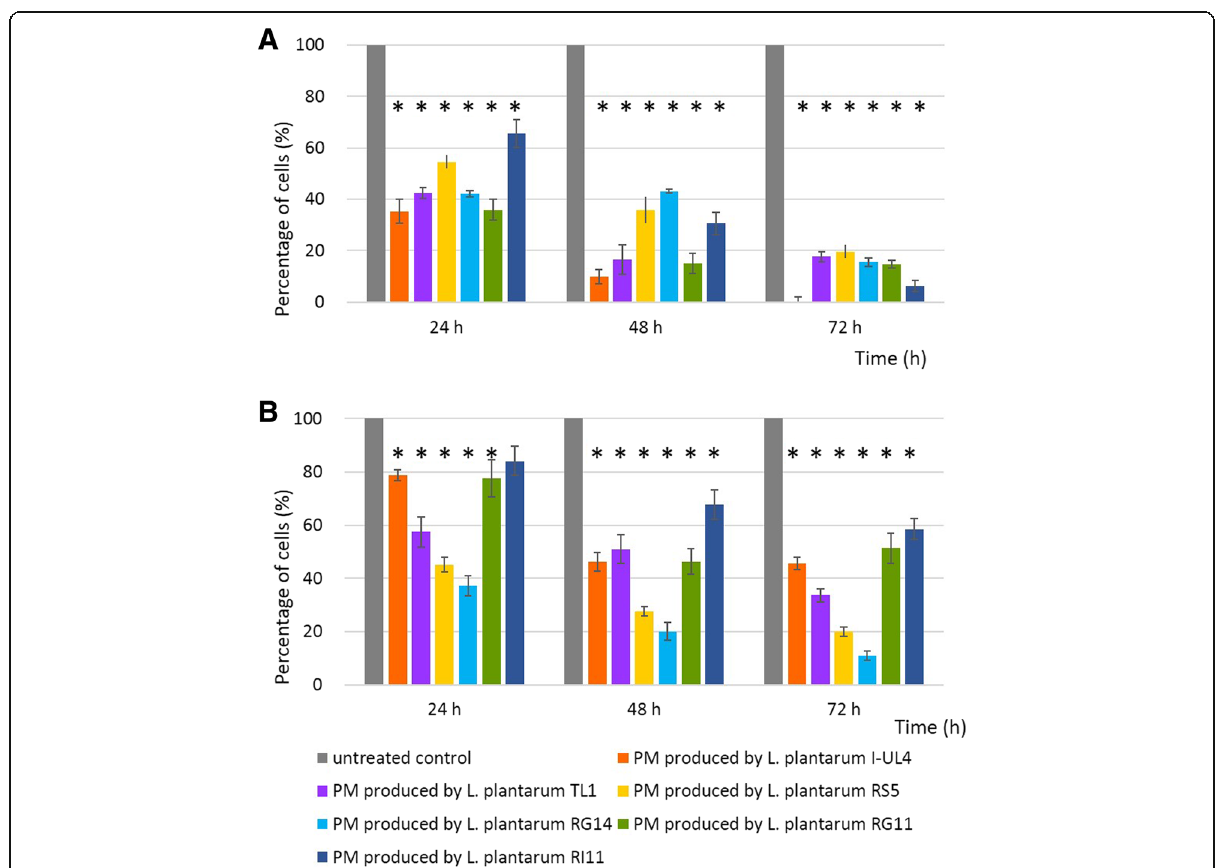
Fig. 2 Antiproliferative effect of 30% (v/v) of PM produced by six strains of Lactobacillus plantarum on ( a ) MCF-7 cells and ( b ) HT-29 cells determined by BrdU cell proliferation assay. Values within the same row and experiment having an asterisk indicate significant differences ( P < 0.05) from the untreated control groups. Error bars represent the standard error of the mean of nine